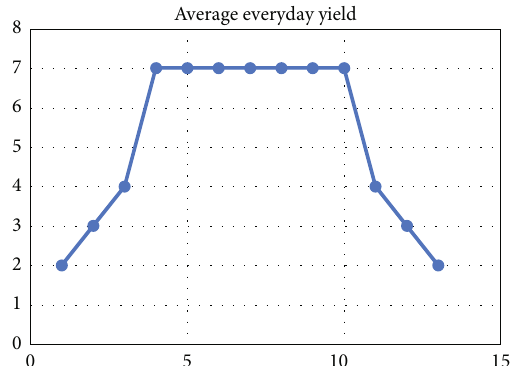
Figure 8: Average everyday yield and load usage.